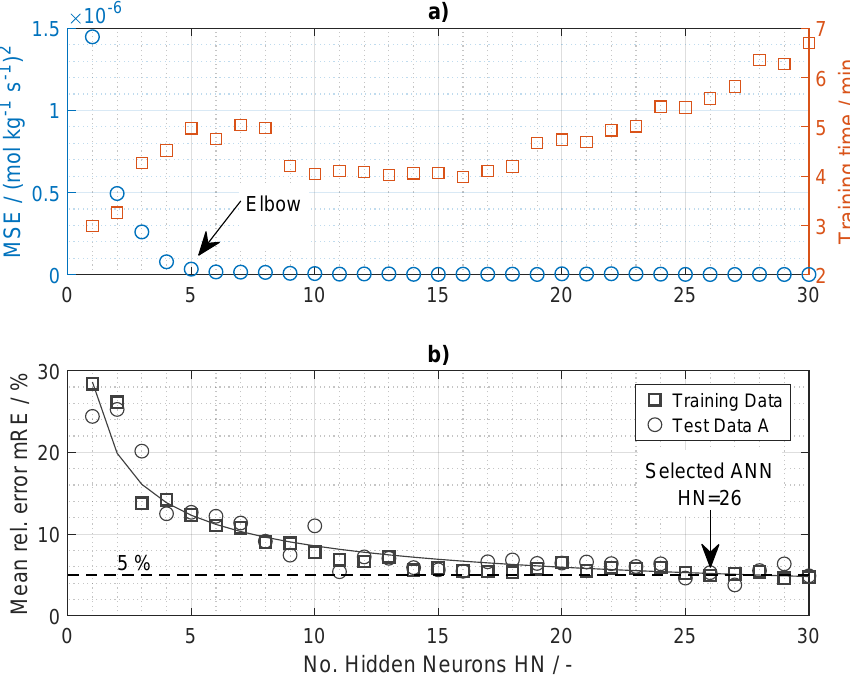
Figure 7. Training results for different architectures of the ANN-HM. ( a ) Mean squared error (MSE) and training time ( b ) mean relative error (mRE) on training and testing data